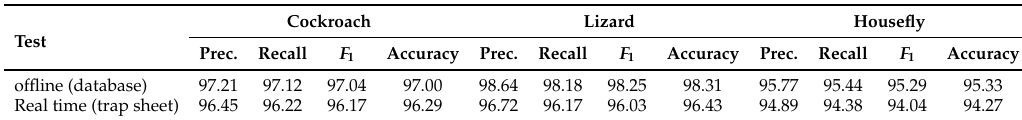
Table 2. Statistical measures for insects detection.